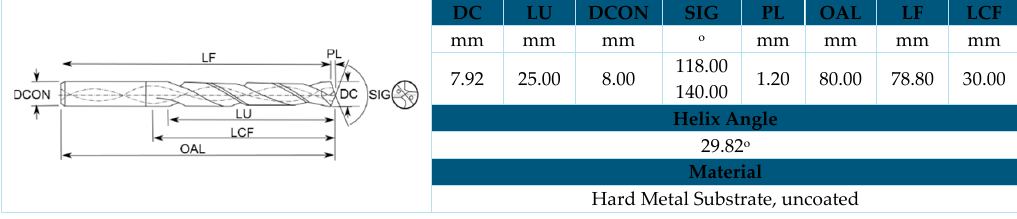
Figure 4. Characteristics of the drill bit used.